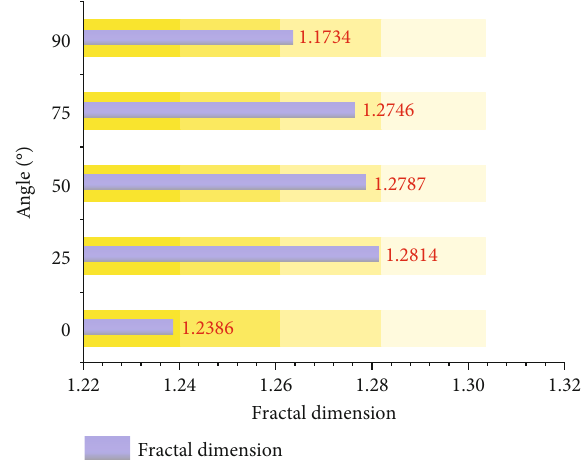
Figure 8: Variation of fractal dimension of cracks under di ff erent joint inclination